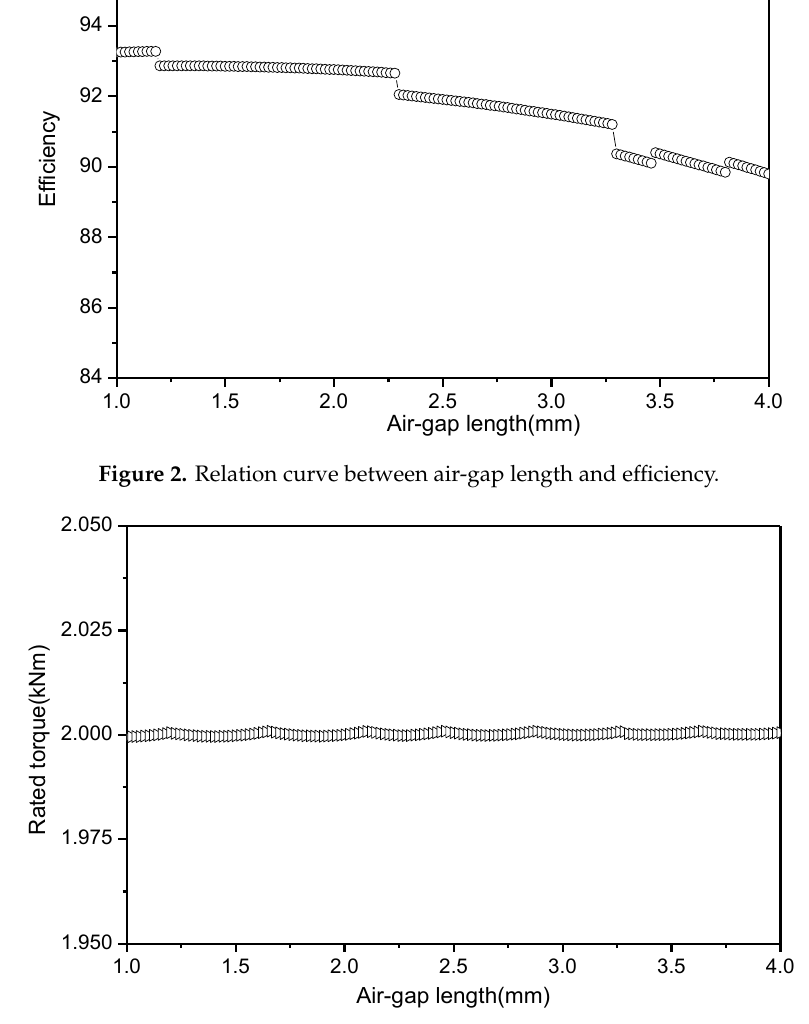
Figure 3. Relation curve between air-gap length and rated torque.